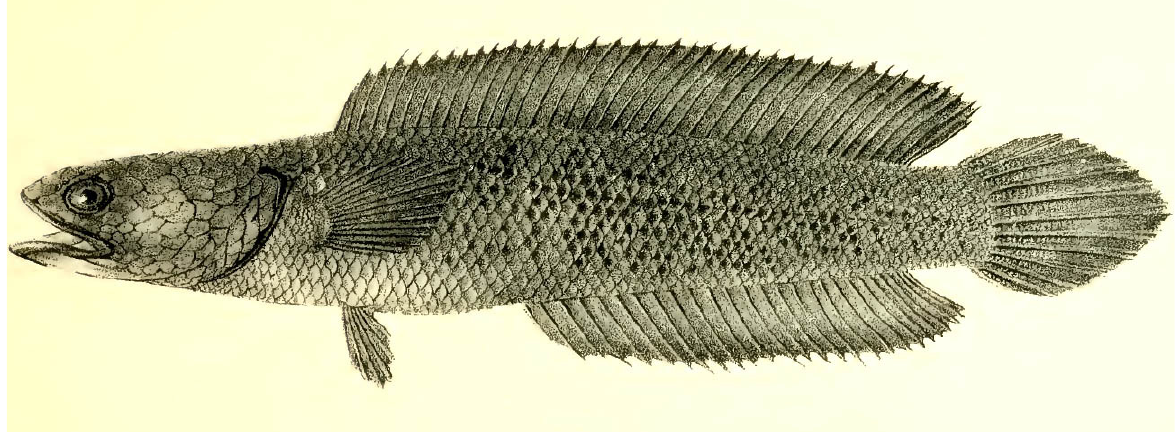
Figure 1. Original drawing of Ophiocephalus stewartii in Playfair (1867: Pl. 3). Image flipped to face